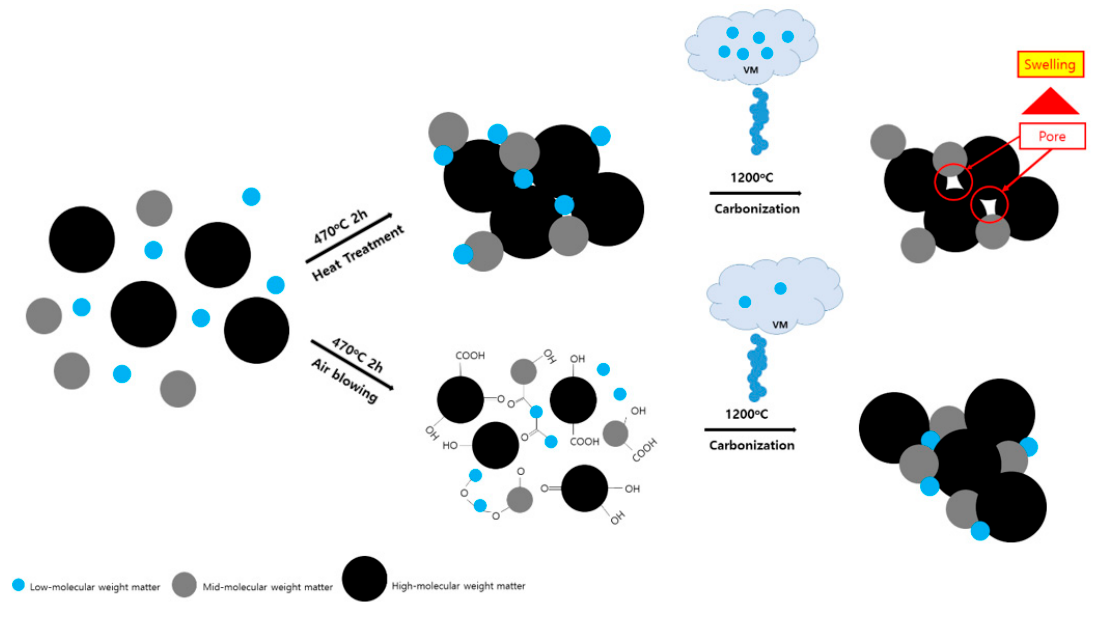
Figure 7. Schematic diagram.